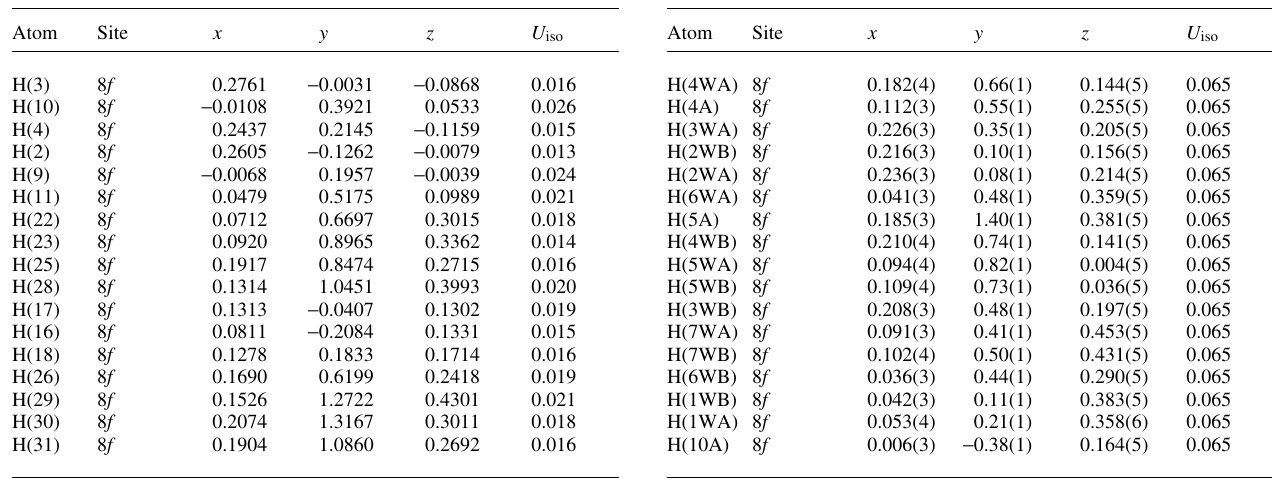
Table 2. Atomic coordinates and displacement parameters (in Å 2 )